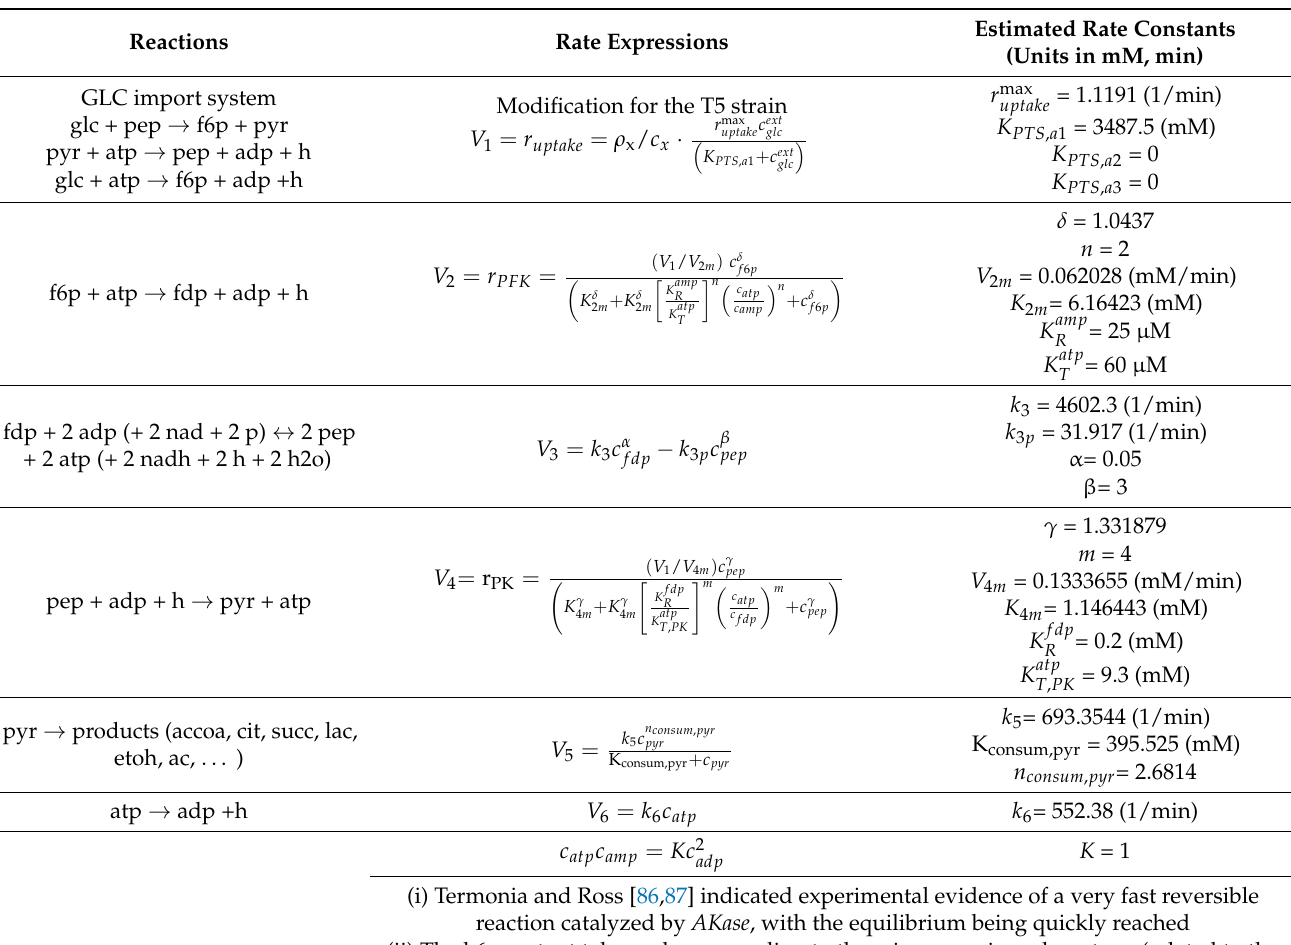
Table 3. Reaction rate expressions V1–V6 of the hybrid model of Table 2, describing the dynamics of the cellular glycolytic species according to the kinetic model of Maria [35,48] and of Chassagnole et al. [52]. In the present study, this glycolysis kinetic model was modified by replacing the PTS system (V1 flux) for the GLC uptake with those of the mutant T5 E. Coli strain tested in this paper. The model rate constants were estimated by Maria [46] to fit the experimental data of Chen [71] (presented in Table 1 and Figures 4–8). Species abbreviations are given in the abbreviation